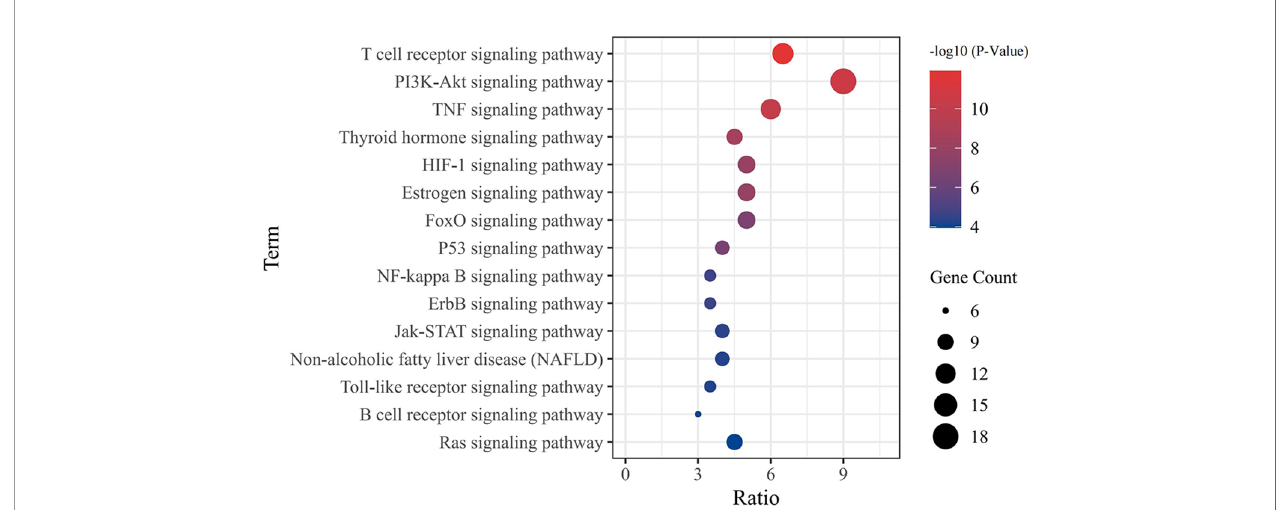
FIGURE 7 | The bubble chart of KEGG pathway analysis (TOP